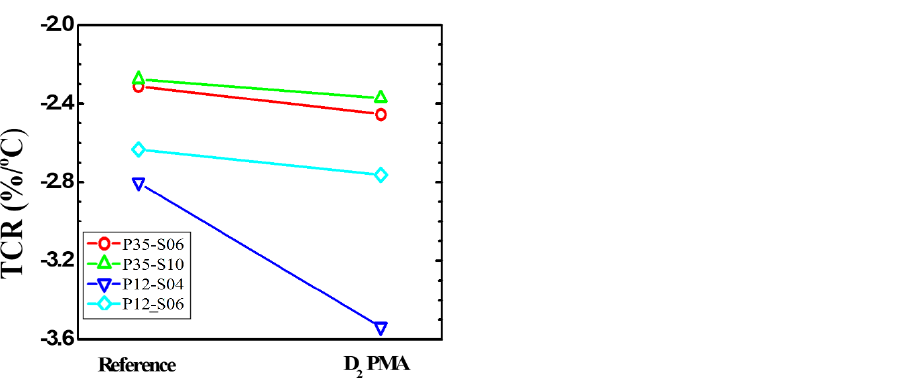
Figure 11. Comparison of TCR values of the four types of a-Si microbolometers treated with the PMA process and the reference devices. Table 4. TCR values of the four types of a-Si microbolometers applied with the PMA process and the increase/decrease rate compared to the reference.